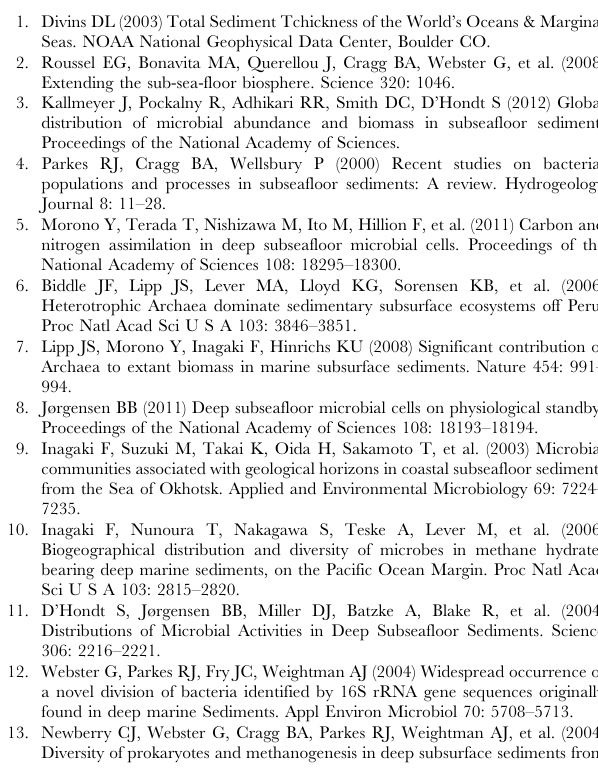
Figure S1 Geochemical depth profiles of: total iron, aluminum, potassium, manganese, total sulfur, silica and titanium concentra- tions in the unfiltered pore waters of the BCK1 core. The blue shade represent important changes in elemental composition profiles. Figure S2 Rarefaction curves for A) archaeal and B) Bacterial 16S rRNA gene libraries. Figure S3 Maximum Likelihood phylogenetic tree of the archaeal 16S cDNA sequences amplified from sections 1, 4, 5, 7 and 8 mbsf (labeled S1, S4, S5, S7 and S8 respectively) of the BCK1 sediment core. Phylogenetic tree was performed using RAxML 7.2.8. and GTRCAT model approximation with 1000 replicates. Only bootstrap values up to 70% are shown. Only one representative sequence ( . 97% identical) per sediment horizon is shown. Number in brackets shown the number of clones analyzed from RNA clone libraries. MBG-D/B, Marine Benthic Group D/ B; TMEG, Terrestrial Miscellaneous Euryarcheotal Group; MCG, Miscellaneous Crenarchaeotal Group; MHVG, Marine Hydrothermal Vent Group; SAGMEG, South Africa Gold Mine Euryarchaeotal Group. Figure S4 Maximum Likelihood phylogenetic tree of the bacterial 16S cDNA sequences amplified from sections 1, 4, 5, 7 and 8 mbsf (labeled S1, S4, S5, S7 and S8 respectively) of the BCK1 sediment core. Phylogenetic tree was performed using RAxML 7.2.8. and GTRCAT model approximation with 1000 replicates. Only bootstrap values up to 70% are shown. Only one representative sequence ( . 97% identical) per sediment horizon is